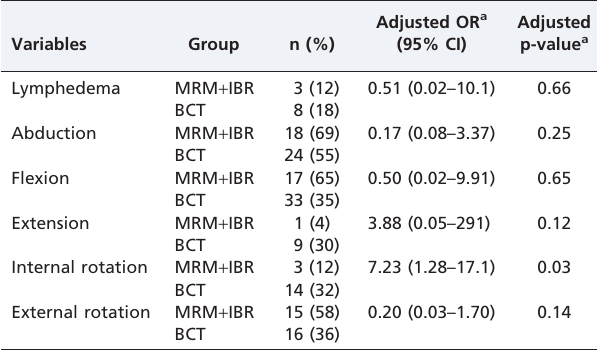
Table 4 - Prevalence of lymphedema and restriction of shoulder movement in breast cancer survivors